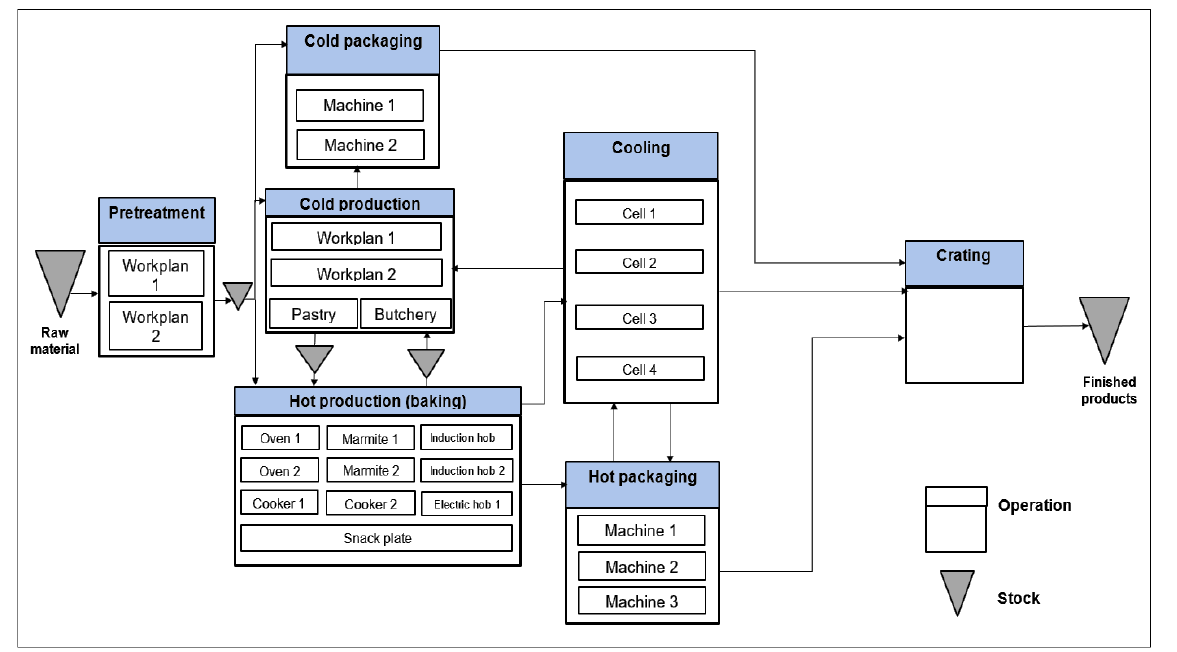
Figure 11. Representation of the studied production system.